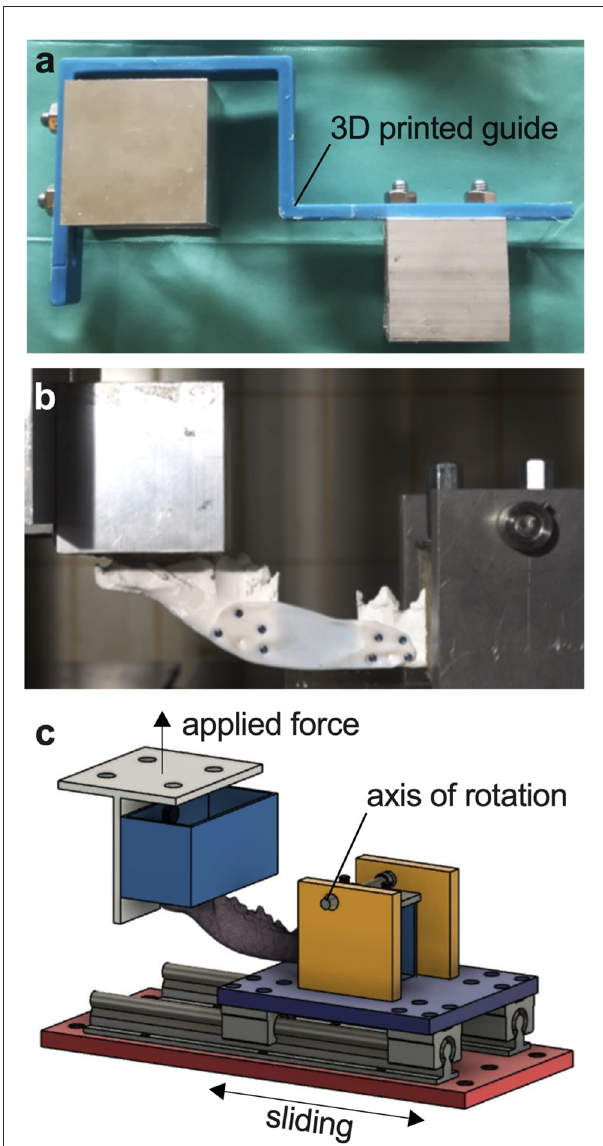
FIGURE3 Servo-hydraulic testing system. (A) Custom 3D printed guide for correct positioning of the mandible. (B) Photograph of a fixated mandible-plate-construct in cantilever bending. (C) Illustration of cantilever bending of a mandible fixated at the ramus and canine teeth in the testing system with applied force perpendicular to the body of the mandible.